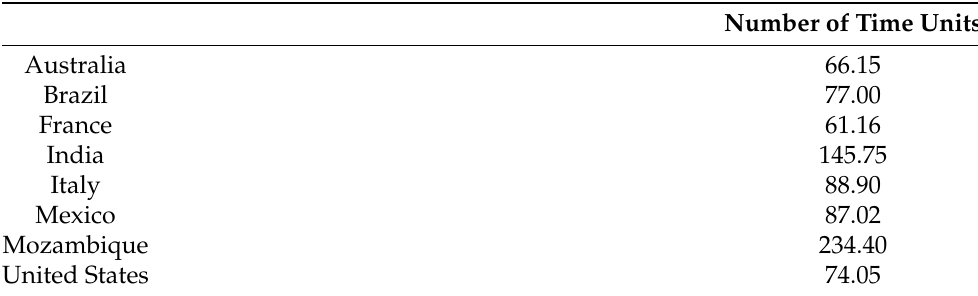
Figure 8. Solution to the SIR model (1), with initial value given by the vector (4), for United States ( left ) and corresponding pattern of τ α , β ( S ( t ) , I ( t )) ( right ). Table 3. Number of time units required to reach the maximum of infected in France, India, Italy, Mexico and the United States, referring to